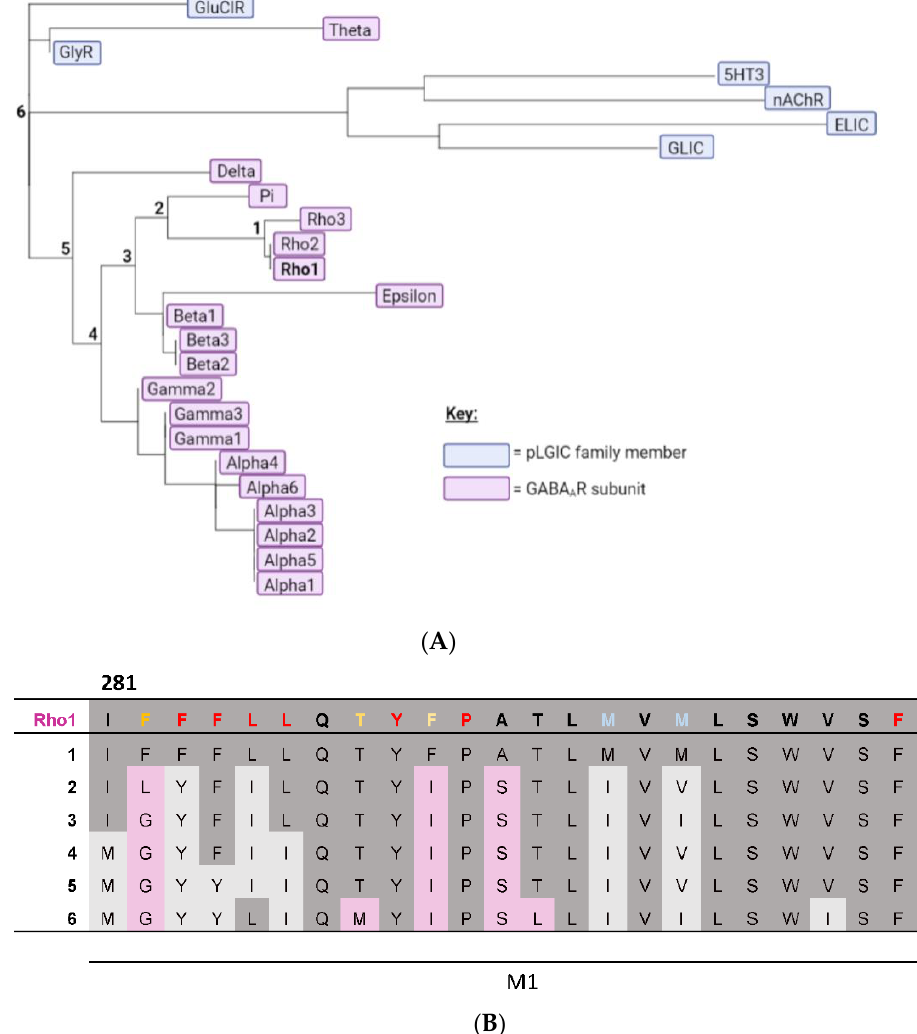
Figure 2. A phylogenetic tree and predicted ancestral sequences. ( A ) A phylogenetic tree of the 19 GABA A R subunits and representative subunits from other pLGIC family members, generated using the PhyML web server. GABA A R subunits are highlighted in pink and pLGIC family members in blue. Branches leading from the GABA A ρ 1 subunit to the most ancestral sequence are labelled 1 – 6. ( B ) A multiple sequence alignment comparing the M1 helix of the GABA A ρ 1 subunit to theoretical predicted ancestral sequences. If a residue is conserved between the GABA A ρ 1 subunit and a given ancestral sequence, it is dark grey; if the general properties of the residue are conserved, residues are light grey; if not, residues are pink. Results from the M1 Ala substitution (Table 1) are also displayed: red = little or no function; orange = reduced function; blue = enhanced function; black = WT-like.